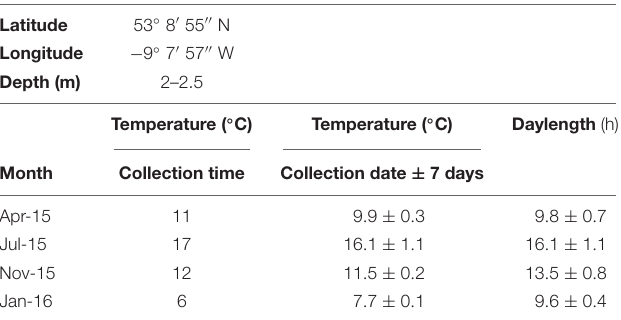
TABLE 1 | Geographic coordinates at Finavarra (FV), western Ireland, where Z. marina shoots were collected, water depth relative to the mean water level, in situ sea surface water temperature (SST) ( ◦ C) measured at times when Z. marina biomass was collected, and averaged SST and daylength